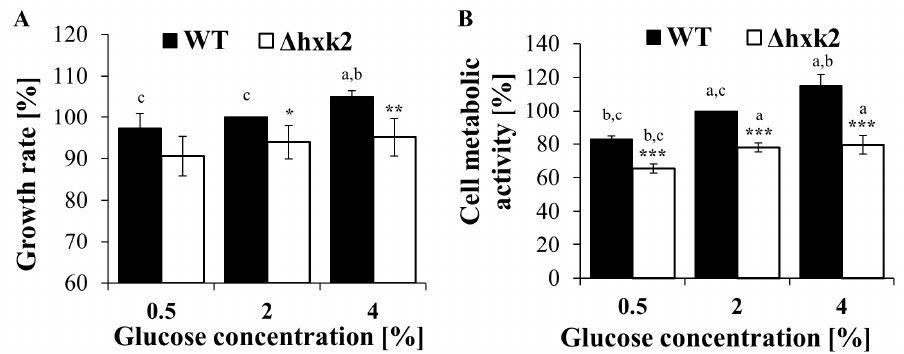
Figure 4. The growth of the yeast cells population and metabolic activity of yeast cells cultured in conditions with di ff erent glucose concentration. ( A ) The growth rate determined on the basis of growth kinetic of yeast cells population; ( B ) overall metabolic activity (an equivalent of cell vitality) of the cell determined with FUN-1 stain. The results are presented as mean ± SD from three independent experiments. * p < 0.05, ** p < 0.01, *** p < 0.001 as compared to the WT strain; a—di ff erent to medium with 0.5% glucose, b—di ff erent to medium with 2% glucose, c—di ff erent to medium with 4% glucose.